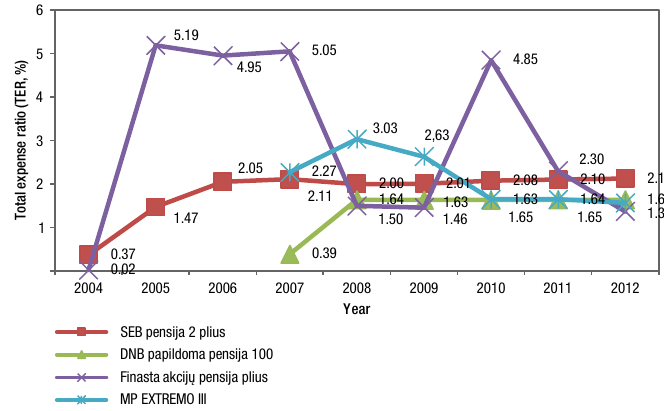
Fig. 10. Change of equity 3 rd pillar PF total expense ratio during 2004–2012 Source : created by authors according to annual reports of